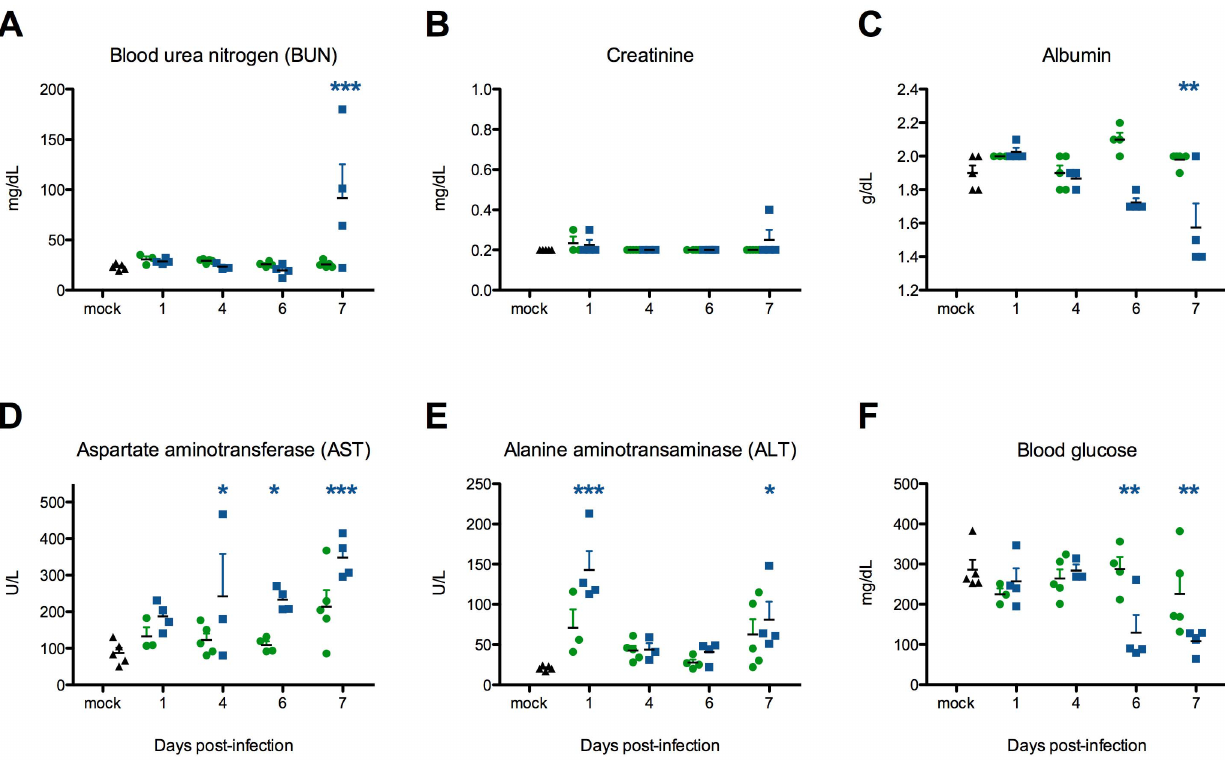
Figure 4. KFDV infection and not AHFV infection resulted in significant biochemical changes, particularly at late time-points post- infection. KFDV infection was associated with (A) elevated BUN, (B) slightly increased creatinine, (C) elevated ALT, (D) elevated AST, (E) hypoalbuminemia and (F) hypoglycemia. Asterisks indicate significant differences between KFDV-infected mice (blue) relative to mock-infected animals (p , 0.05). No alterations in clinical chemistry values were significant in AHFV-infected mice (green). On each day, data was collected from a minimum of 3 and a maximum of 5 mice per group.